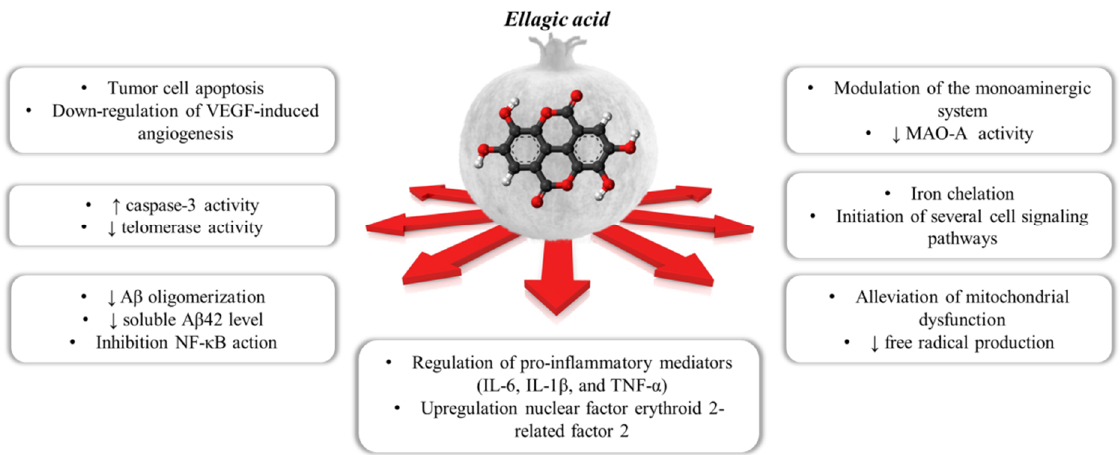
Figure 1. The polypharmacological effects regulated by ellagic acid contained within the pomegranate.